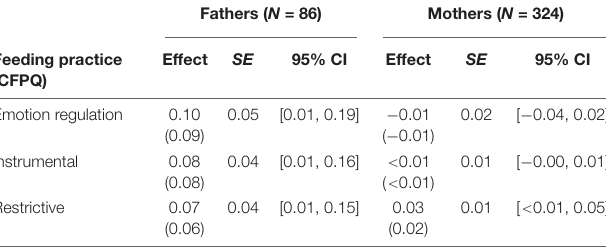
TABLE 5 | Results for conditional indirect effects by parent